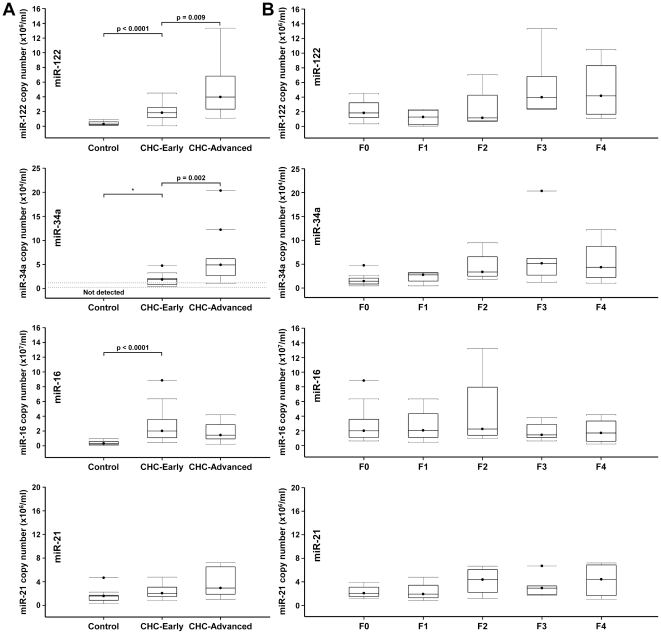
Serum levels of miR-122, miR-34a, miR-16 and miR-21 and histological liver disease severity in CHC patients.CHC group was subdivided into (A) CHC-early (F0-F1) and CHC-advanced groups (F3-F4) and (B) further subdivided according to individual fibrosis stage.